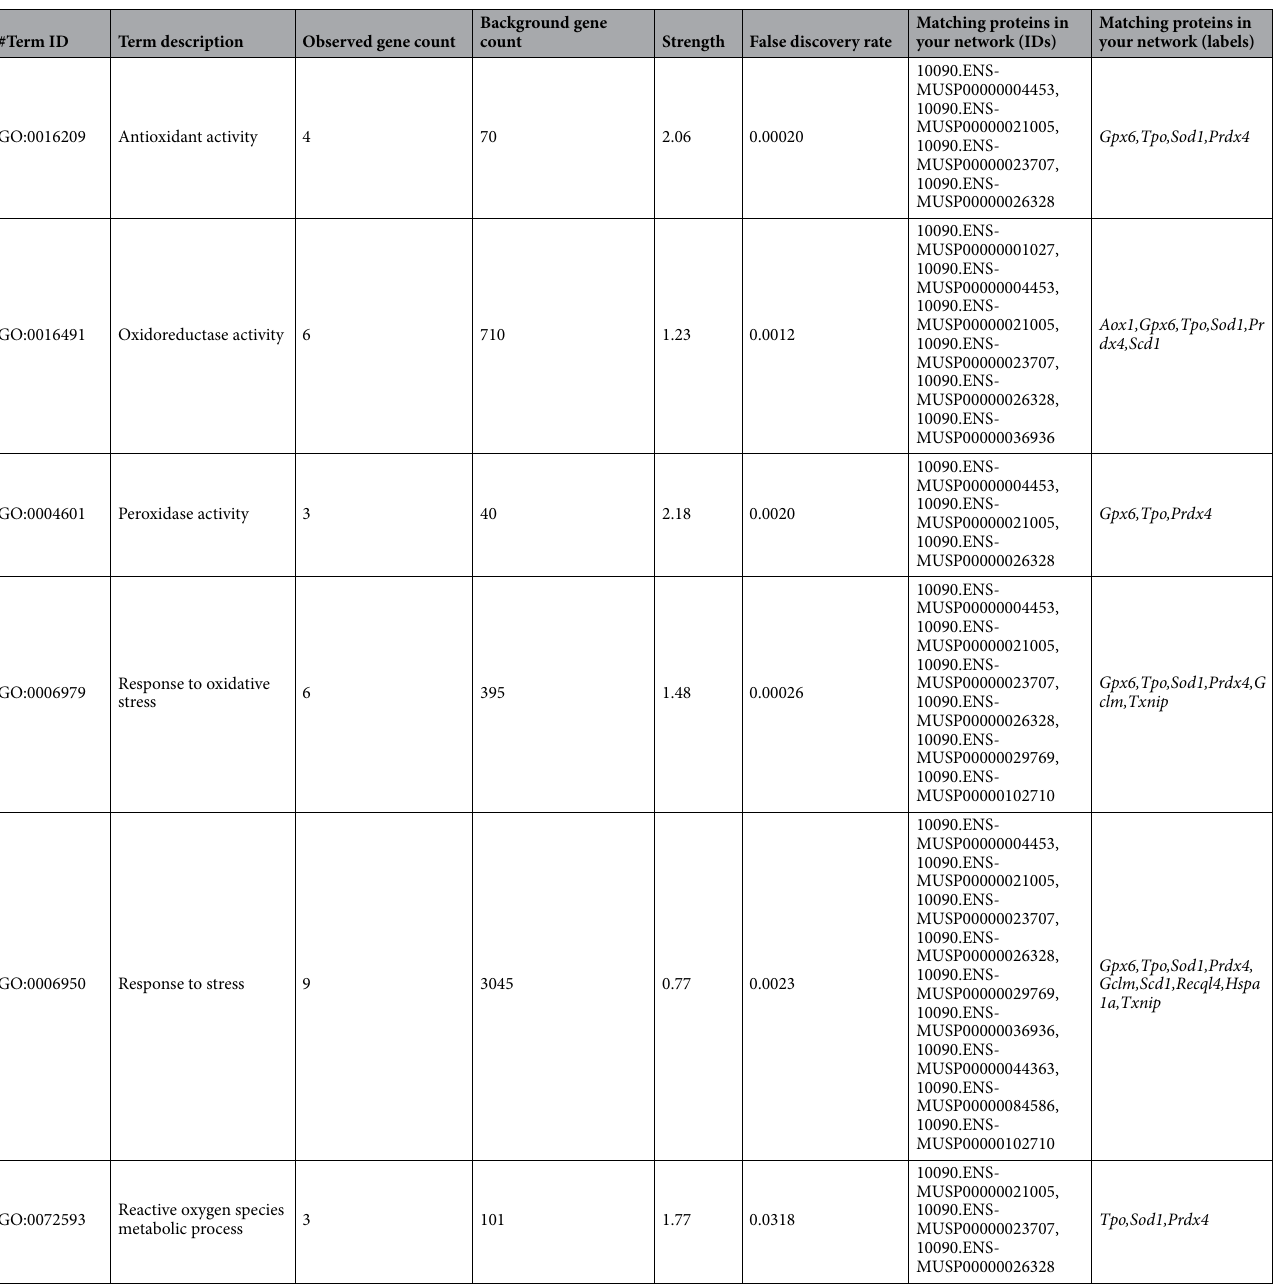
Table 2. Function and process pathway analysis by using the GO data base of cluster